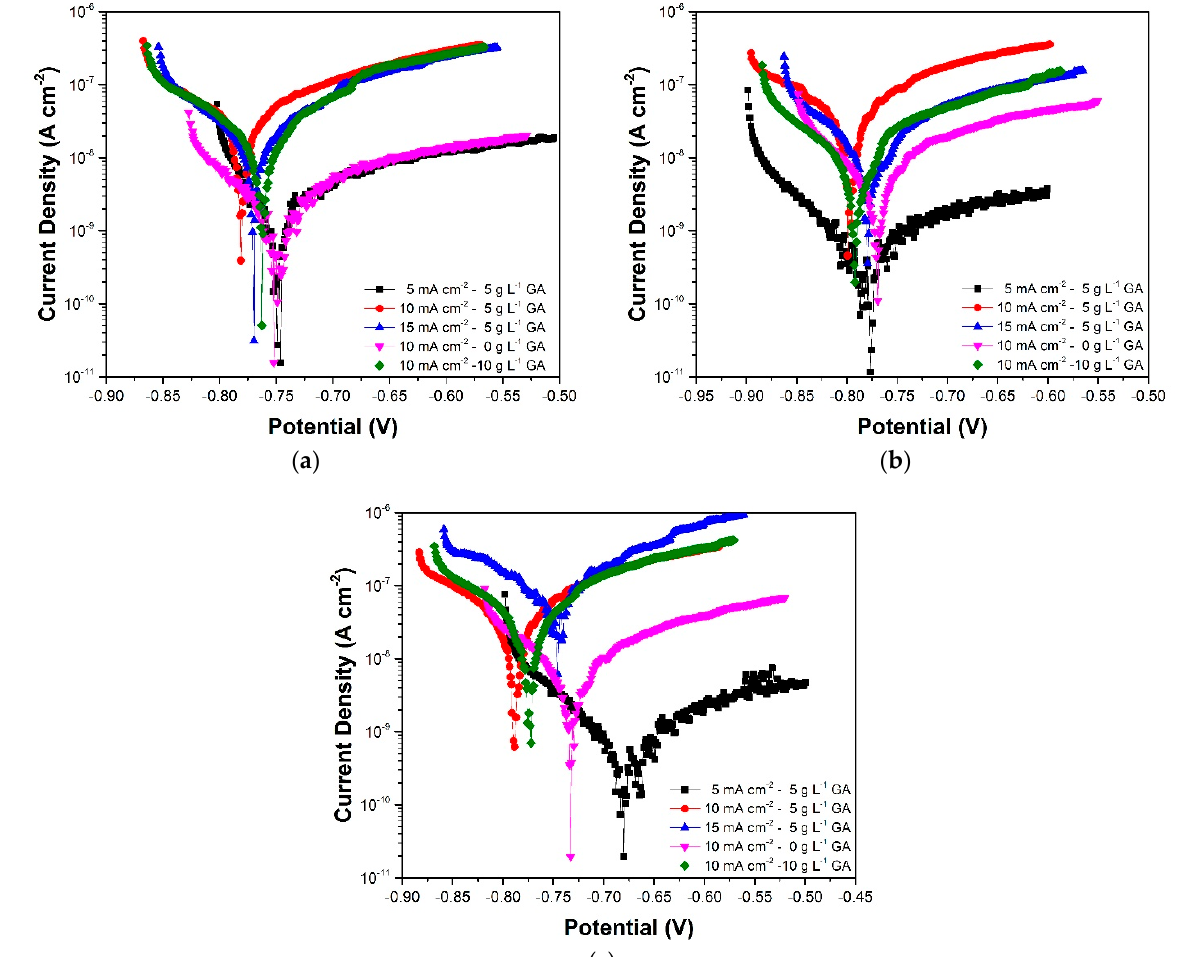
Figure 9. Tafel plots of the anodized aluminum samples acquired after ( a ) 3 days, ( b ) 7 days, and ( c ) 10 days of immersion in 3.5 wt. % NaCl.